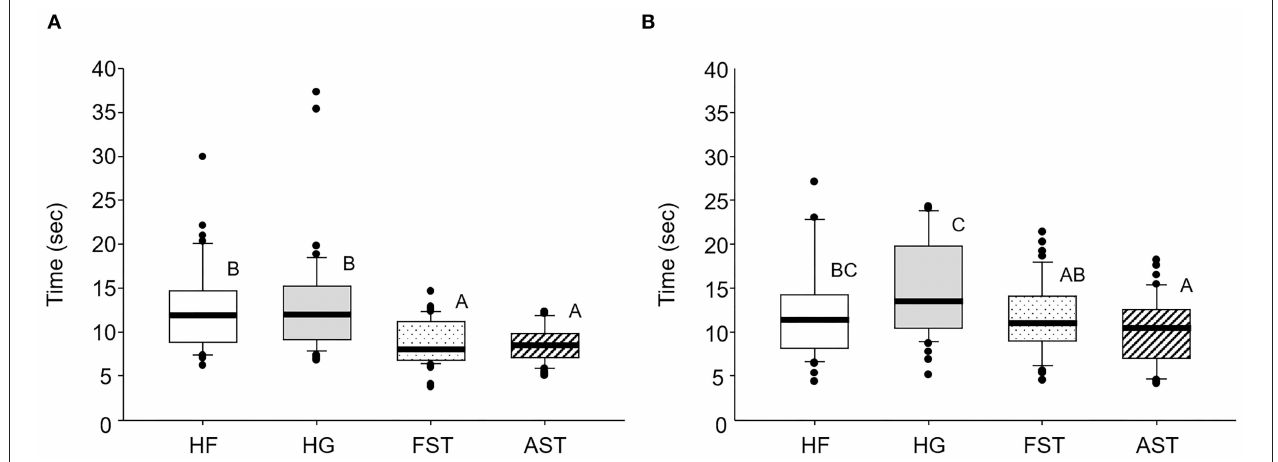
FIGURE 2 | Box plots of movement activities of 2 hybrids and conspecific colonies. (A) Passing time and (B) stop time. Different upper caste letters indicates statistical difference according to Tukey’s HSD ( α = 0.05). Line on the box represents mean and circles above and below box indicate outliers. HF ( ♀ AST × ♂ FST),